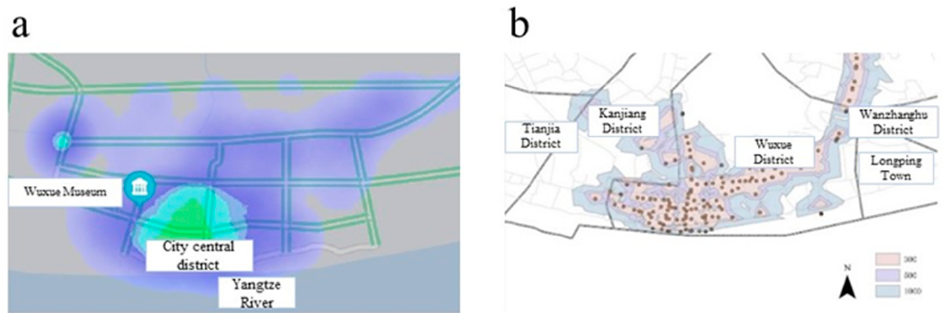
Figure 14. Analysis of bus station distribution. ( a ) Distribution of activity in the central urban area of Wuxue city. ( b ) Distribution of bus stops and service area.